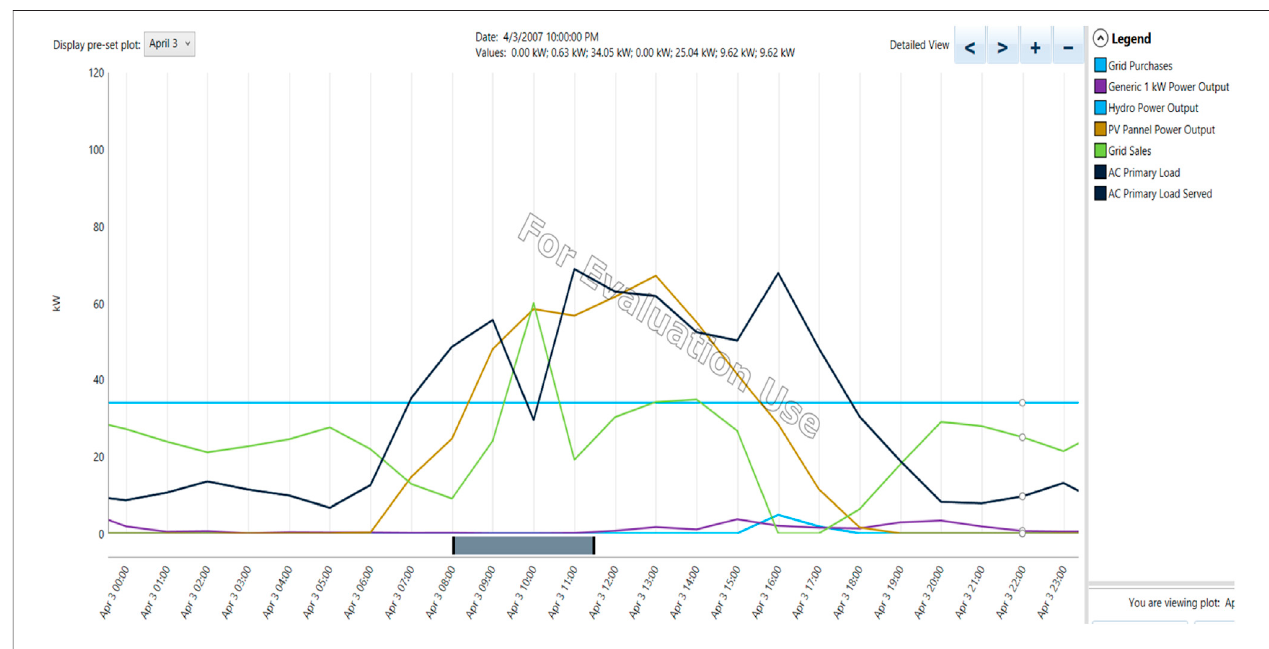
FIGURE 5 | On-line energy scheduling for April 3.